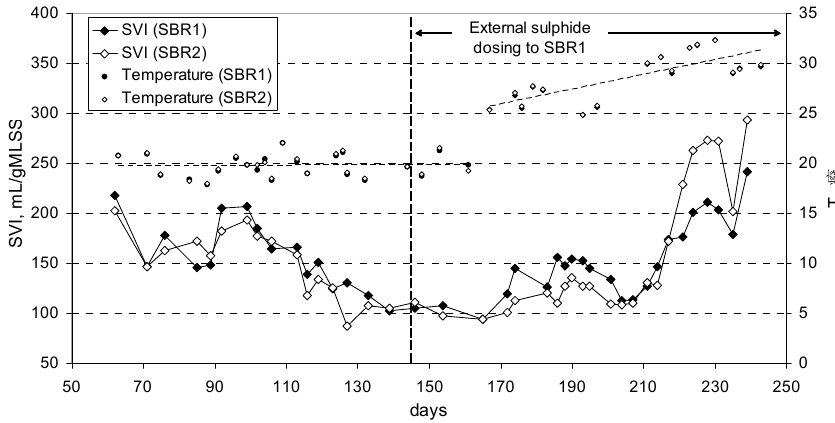
Figure 4. Sludge volume index and temperature trend in the